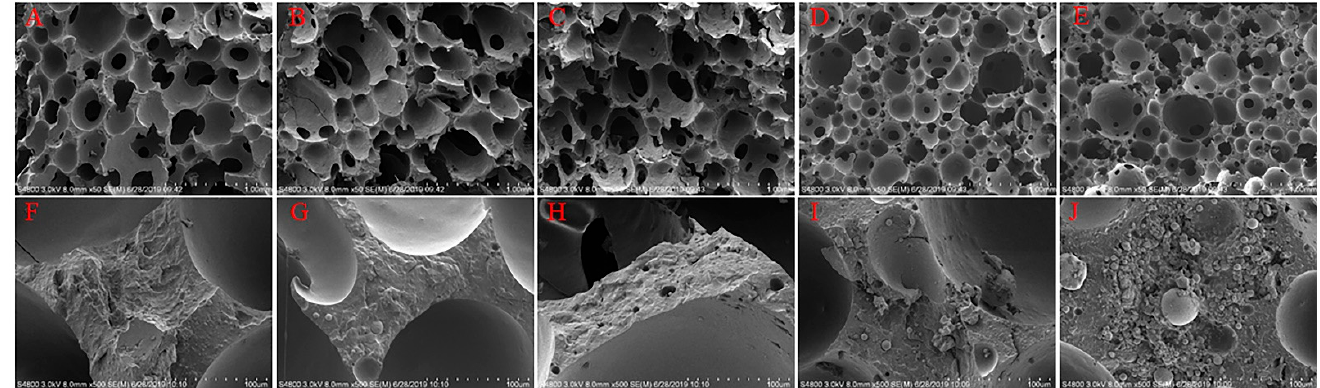
Figure 7. SEM images of the control group ( A – E ) and the experimental group ( F – J ) containing 5, 10, 15, and 20 wt% of HCM. Row 1 and 2 separately has a magnification of 8.00 mm × 50 and 8.00 mm × 500.